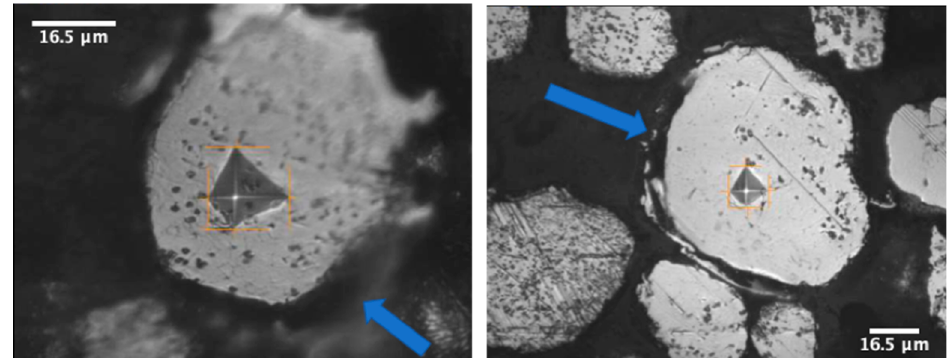
Figure 5. The defocused nature of the micrograph following microindentation testing as well as the asymmetry of the four-sided pyramidal impression demonstrates the occurrence of particle immersion during Vickers hardness testing of a metallic particle ( Left ). At the same time, the ( Right ) micrograph presents particle immersion into the mounting material following particle decohesion from the matrix material during Vickers indentation loading as highlighted by the perimeter identified with the blue arrow(s).